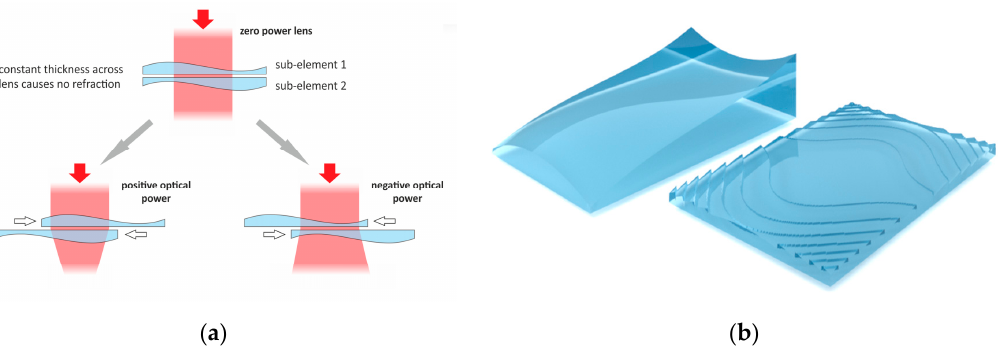
Figure 1. Working principle of the Alvarez lens: ( a ) a modulation of the optical power is obtained when conjugate phase plates are shifted with respect to each other in the direction where their phase profile is anti-symmetric. Depending on the displacement of the sub-elements from their zero position, a lens with positive or negative optical power is generated. ( b ) A refractive Alvarez sub-element with a profile function proportional to x 3 /3 + xy 2 and the corresponding diffractive Alvarez sub-lens, the phase pattern of which is generated by taking the refractive phase structure modulo 2 π , are shown. Reprinted with permission from [77]. Copyright 2017 Optical Society of America.